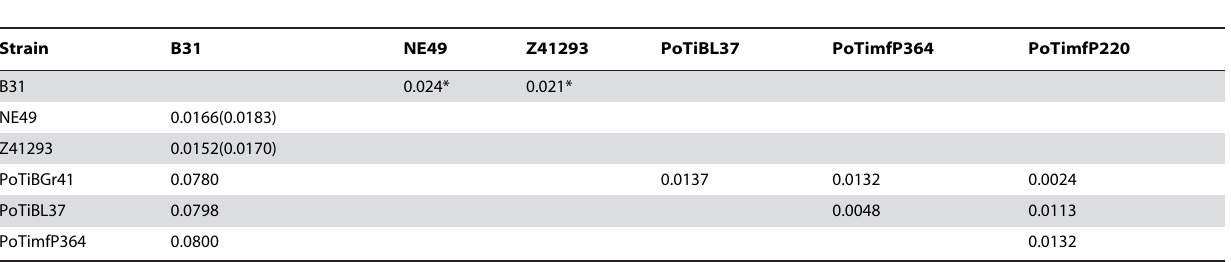
Table 5. Pairwise genetic distance among of housekeeping genes of selected B. lusitaniae samples and B. burgdorferi strains B31, NE49 and